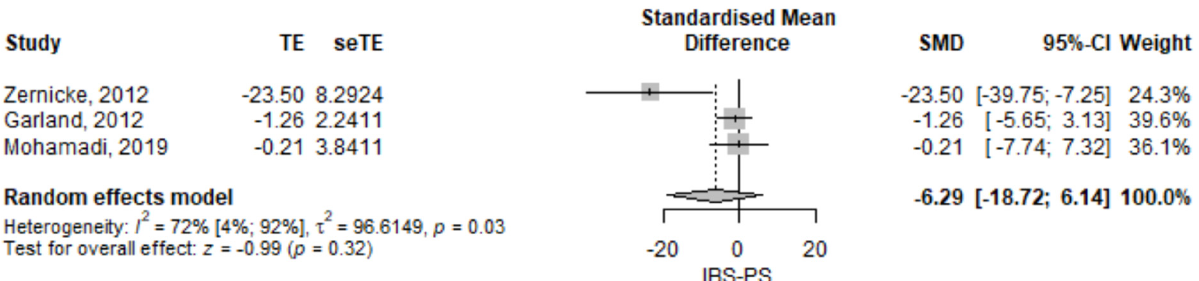
6 of 13 Figure 3. Irritable bowel syndrome quality of life—standardized mean difference comparison be- tween mindfulness intervention and control. IBS-QOL, irritable bowel syndrome quality of life; SMD, standardized mean difference; TE, treatment effect as SMD; seTE, standard error of the treatment effect; CI, confidence interval [15,17,18,20,21].